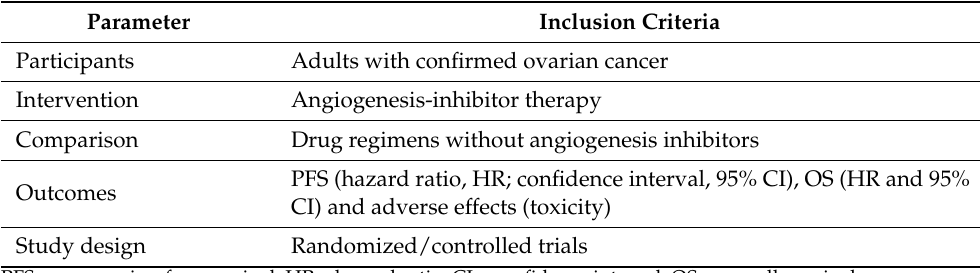
Table 1. PICOS criteria for inclusion of